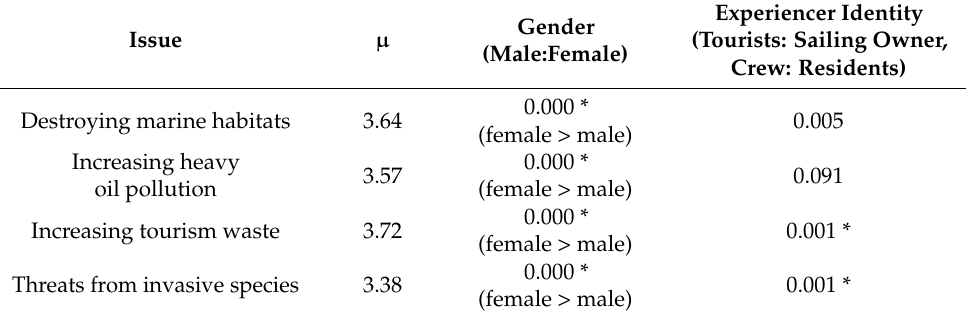
Table 8. Perception analysis of the impact on the marine ecological